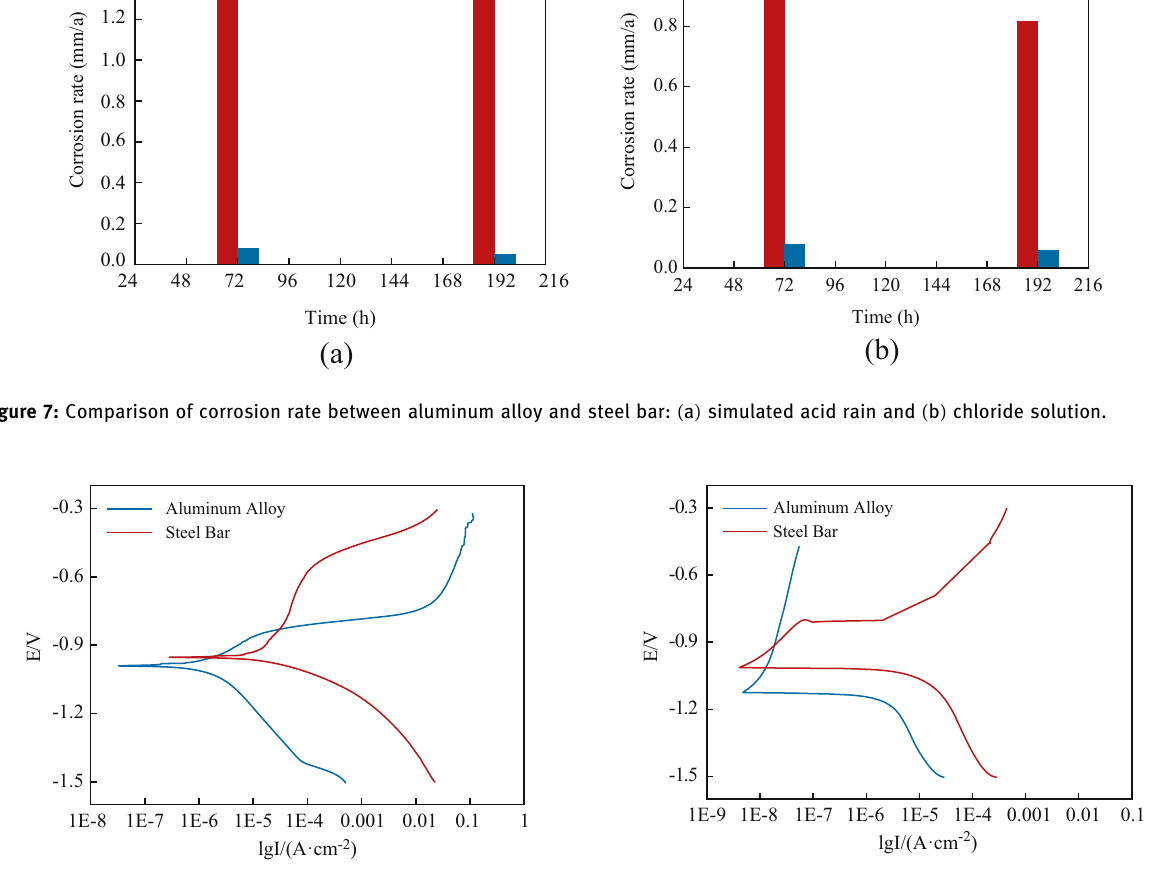
Figure 8: Polarization curves of aluminium alloy and steel bar in chloride solution.